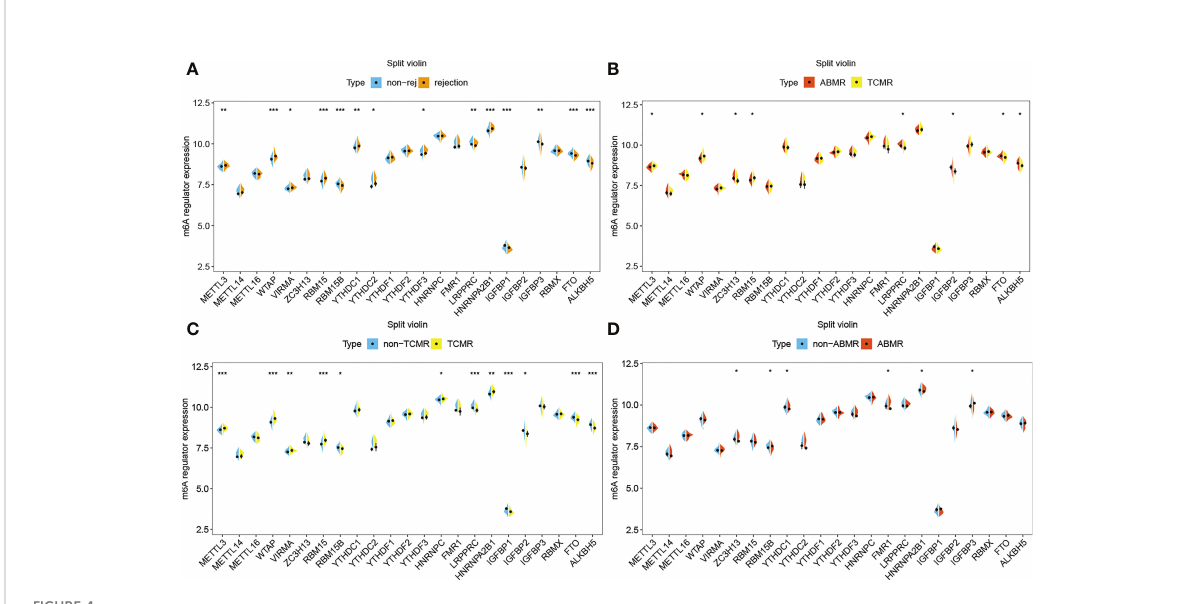
FIGURE 4 m6A regulators in rejection subtypes. (A) Split violin plot of m6A regulators ’ gene expression levels in non-rejection versus rejection group, (B) ABMR versus TCMR group, (C) non-TCMR versus TCMR group, and (D) non-ABMR versus ABMR group. *P< 0.05, **P< 0.01, ***P< 0.001.